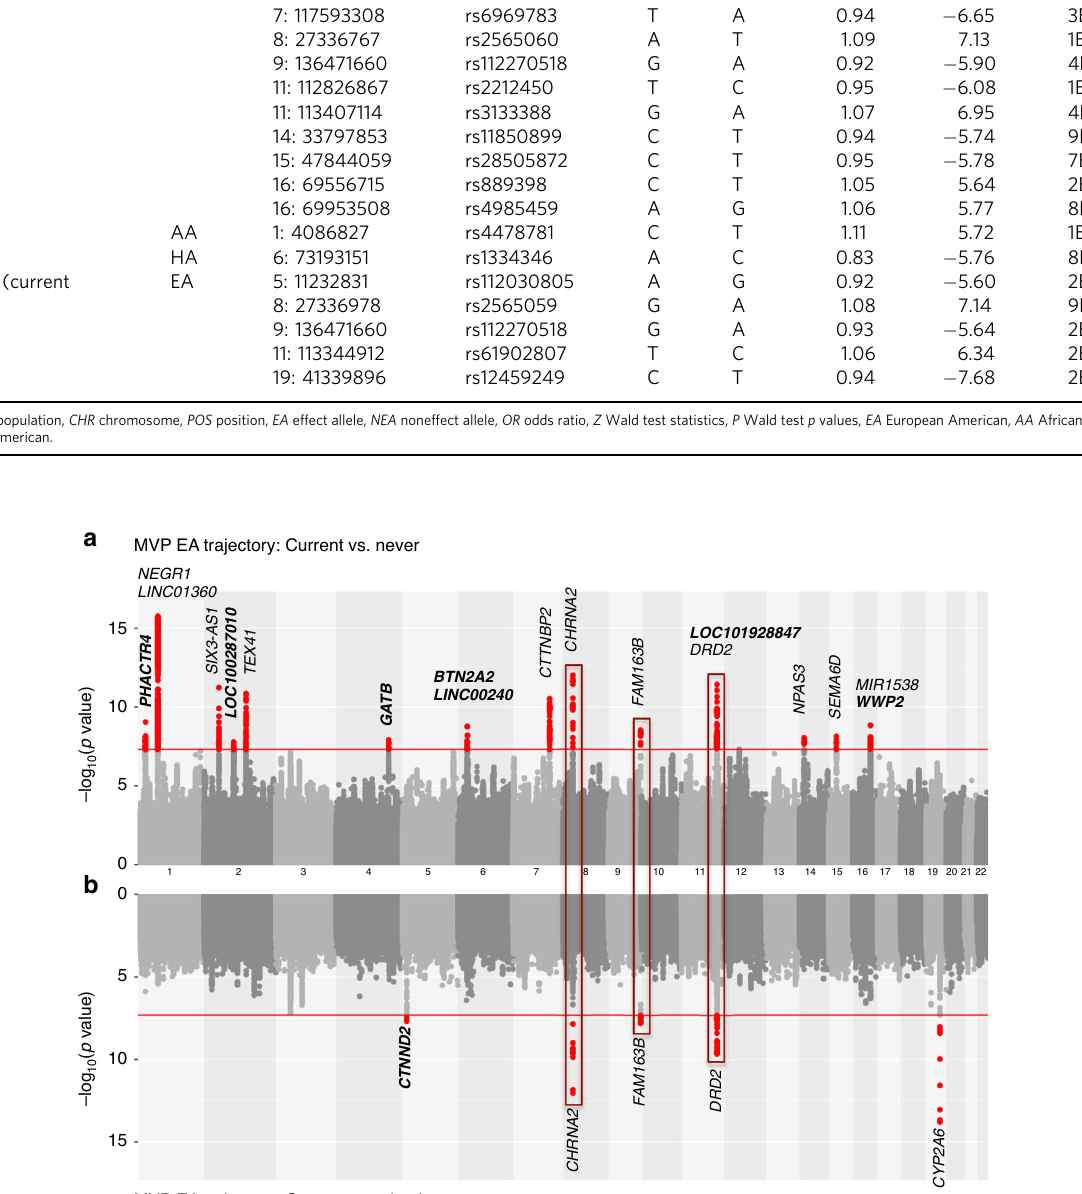
Fig. 2 Genome-wide association study results for smoking trajectory contrasts. Mirror Manhattan plots for smoking trajectory contrast I (current vs. never ( a )) and contrast II (current vs. mixed ( b )) in European American samples in the Million Veteran Program. Genome-wide signi fi cant loci are highlighted in red and mapped to genes by the nearest location. Genes have not been previously reported to be associated with smoking phenotypes in other studies are marked in bold. Three loci shared by contrast I (current vs. never) and contrast II (current vs. mixed) are highlighted in red